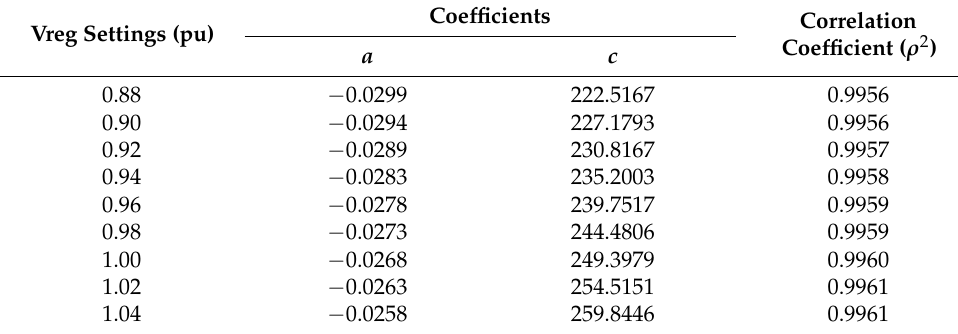
Table 1. Coefficients to estimate maximum voltage in the network.